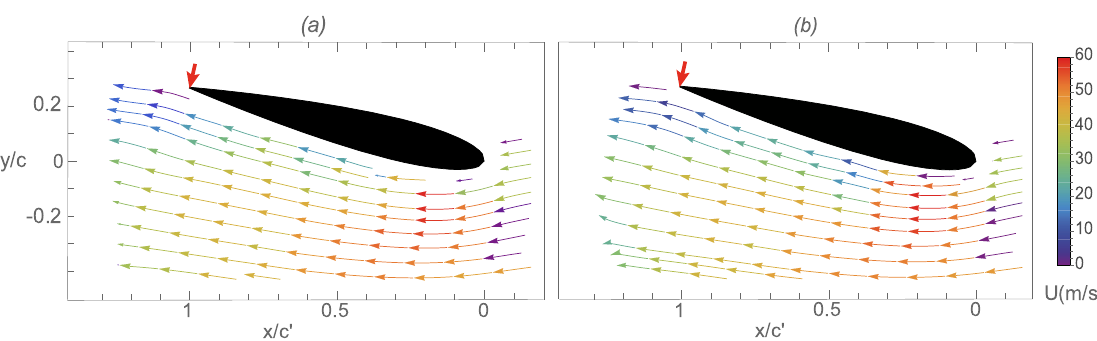
Figure 18. ( a ) Plasma-off and ( b ) plasma-on flow field at T D for α = 14.5 ◦ and U ∞ = 30 m/s.